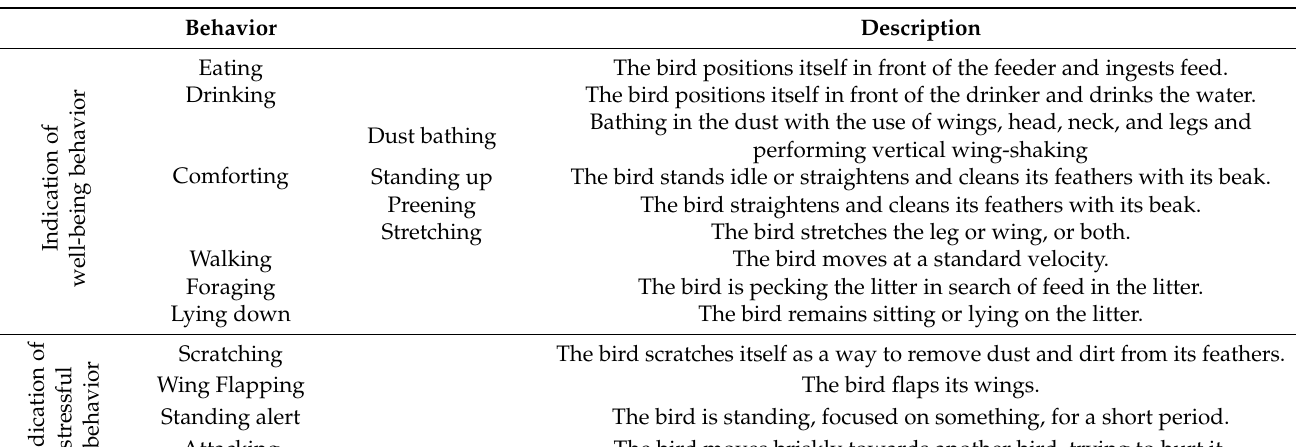
Table 1. The ethogram used to identify the birds’ reactions during the